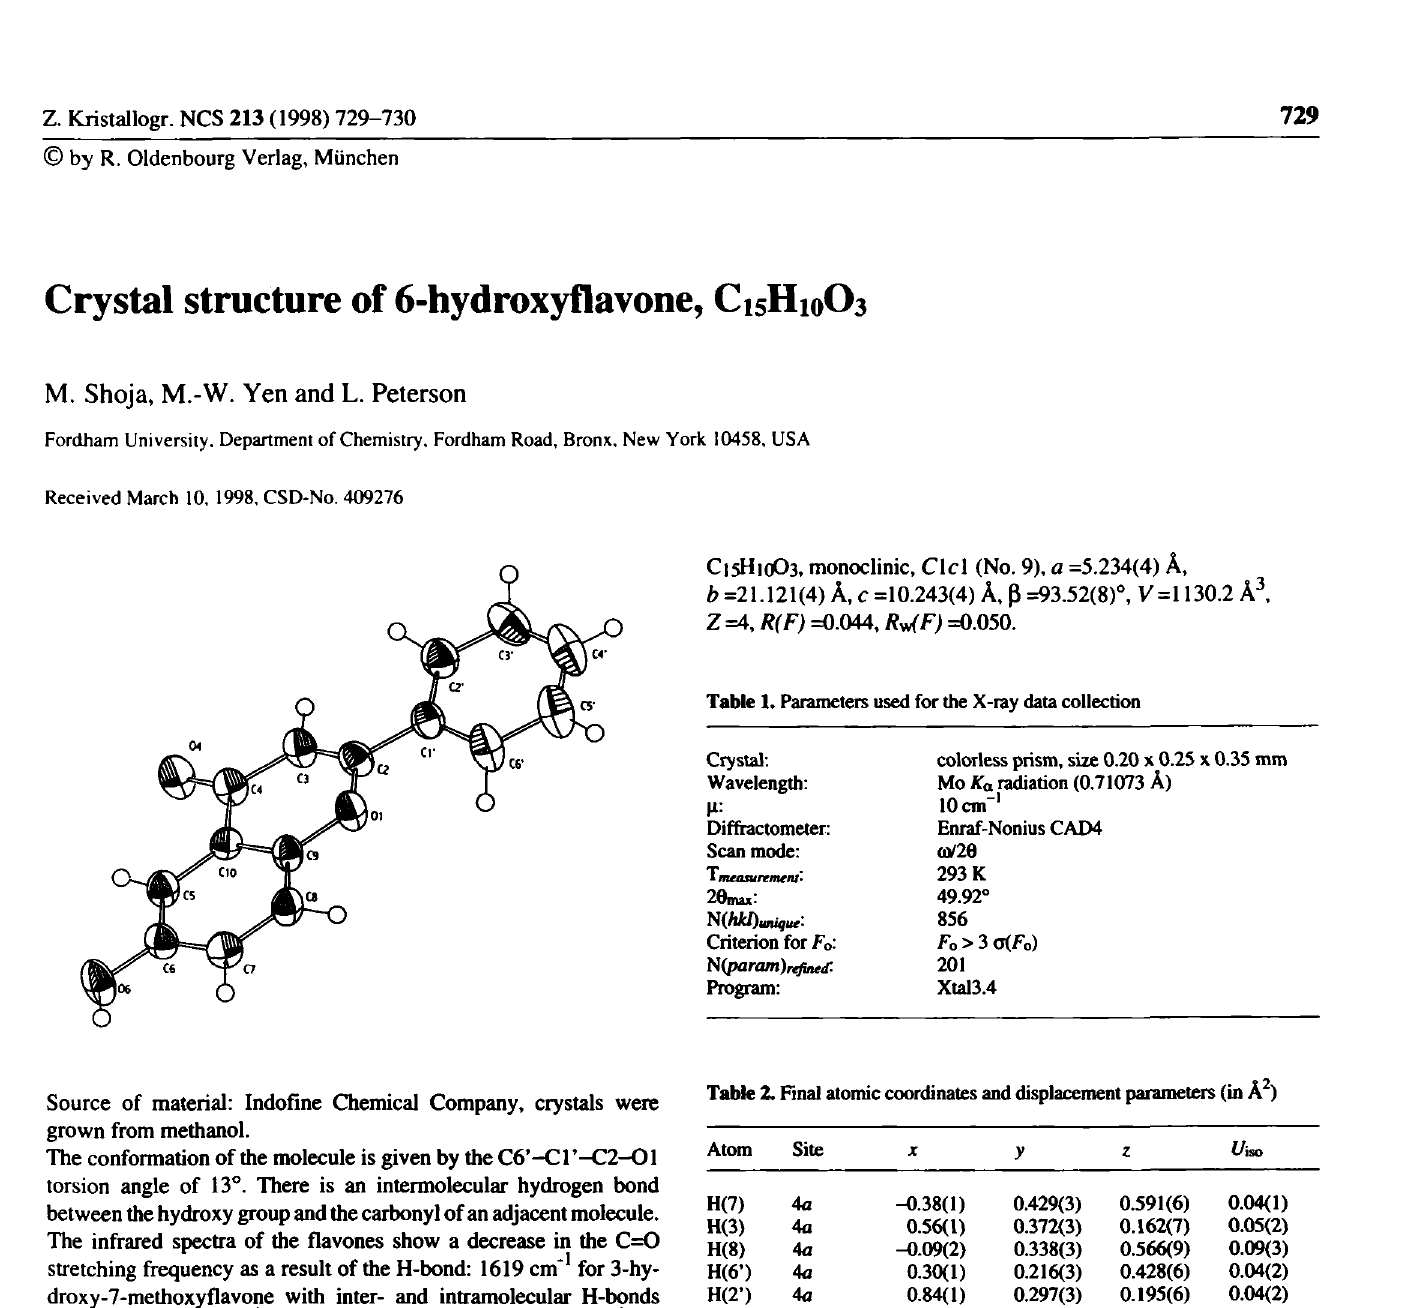
Table 3. Final atomic coordinates and displacement parameters (in Â^)